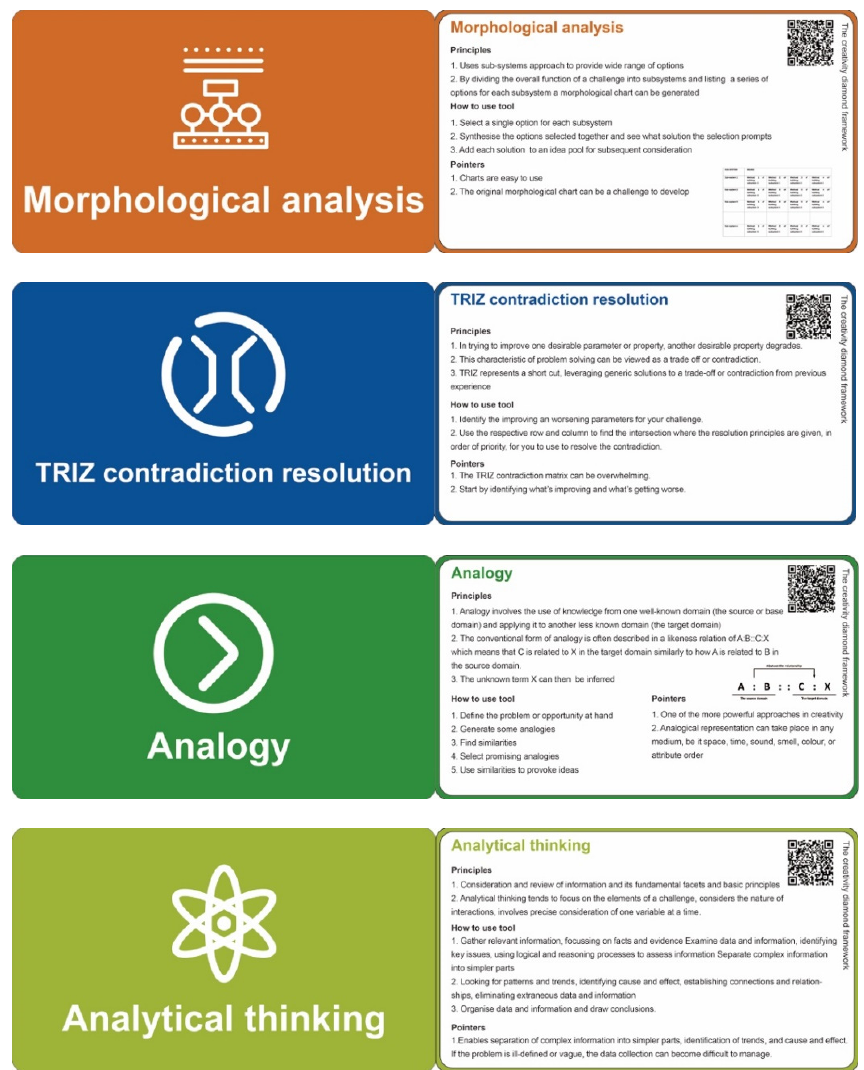
Figure 12. Examples of resource cards for some of the creativity tools.